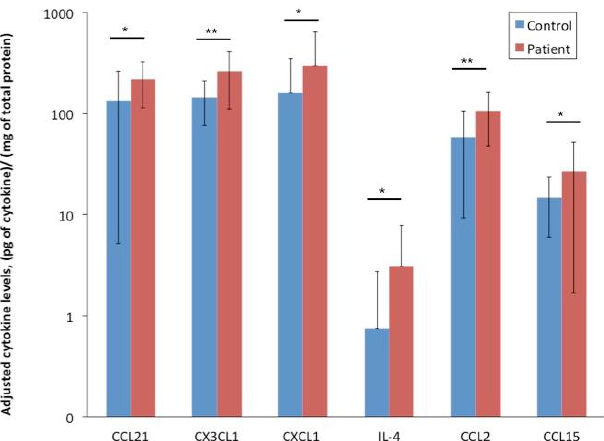
Figure 2. Elevated cytokine levels in the saliva of radiated head and neck cancer patients and healthy controls. Multiplex assay measurement of the cytokine levels in the patients’ saliva after radiotherapy revealed significantly higher levels of CCL21, CX3CL1, CXCL1, IL-4, CCL2, and CCL15, when compared to the controls. * represents p < 0.05; ** represents p < 0.01.